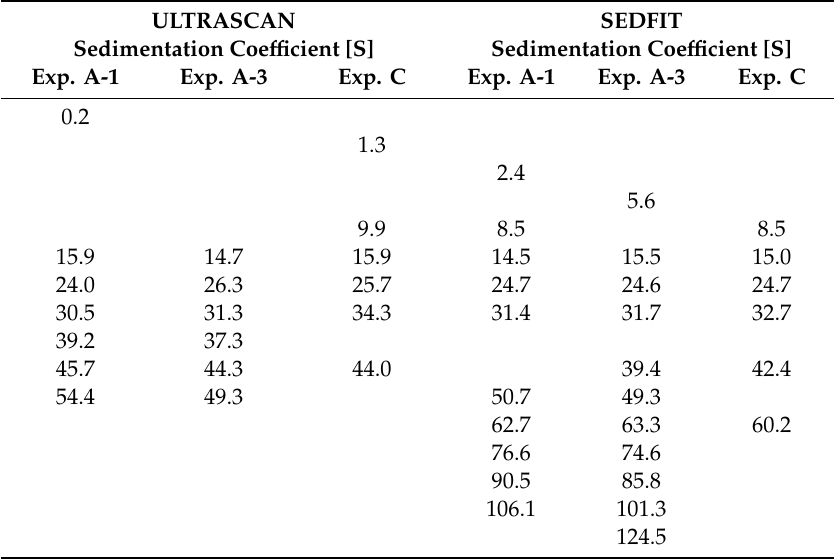
Table 3. Overview of the di ff erent cluster species found in the ULTRASCAN analysis of exp. A-1, A-3, and C and the SEDFIT analysis of the same